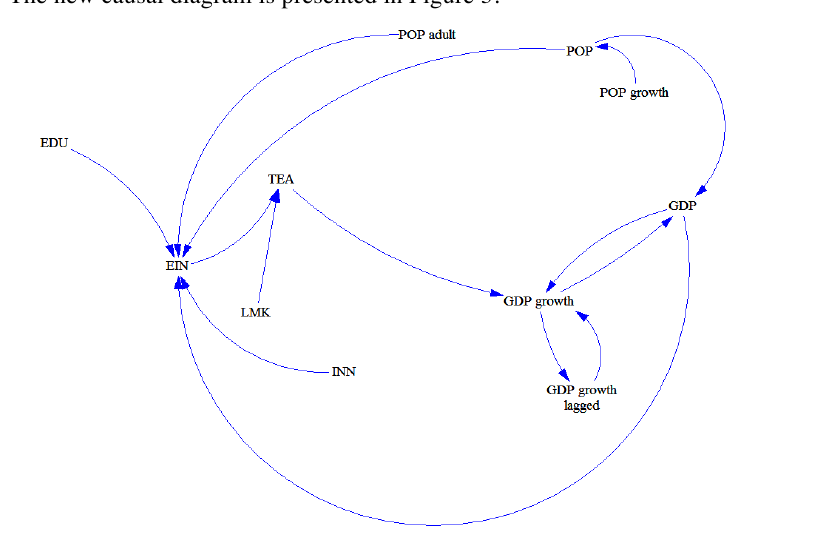
Fig. 3 . Modified causal diagram used in the